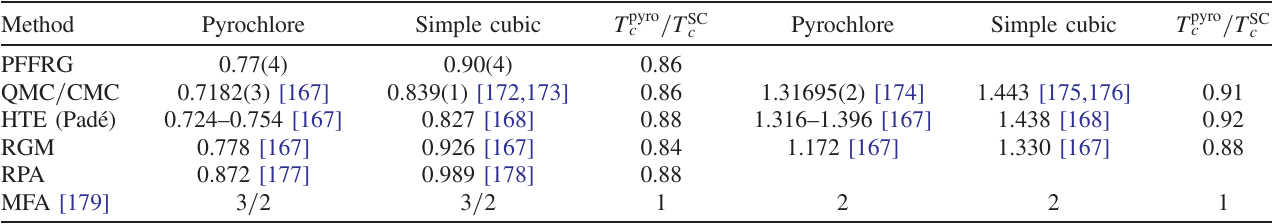
TABLE II. The ordering (Curie) temperatures for the S ¼ 1 = 2 nearest-neighbor quantum Heisenberg ferromagnet (in units of T c = j J 1 j ) (columns 2 and 3) and its corresponding classical ( S → ∞ ) model (in units of T c = ½j J 1 j S ð S þ 1 Þ(cid:2) ) (columns 5 and 6) on the pyrochlore and simple cubic lattices as obtained by PFFRG and compared with estimates obtained from quantum Monte Carlo (QMC), classical Monte Carlo (CMC), high-temperature expansion (HTE), rotation-invariant Green ’ s function method (RGM), and random-phase- approximation (RPA). The fact that T pyro c =T SC c < 1 can be attributed to finite-temperature frustration effects [167]. We also quote the result in the mean-field approximation (MFA), which is insensitive to the difference between the pyrochlore and simple-cubic lattice, since it depends only on the coordination